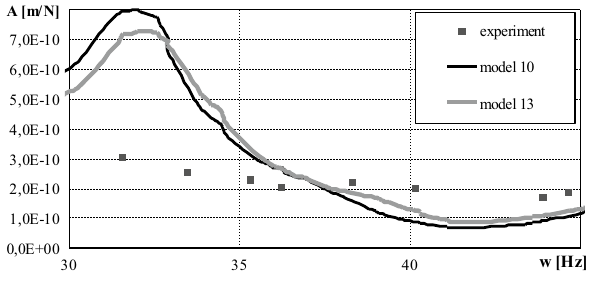
Fig. 15 Amplitude dependences of the forced oscillations of the support No. 4 on the frequencies for models 10 (basic) and 13 (tak- ing into account the rigidity of the generator)